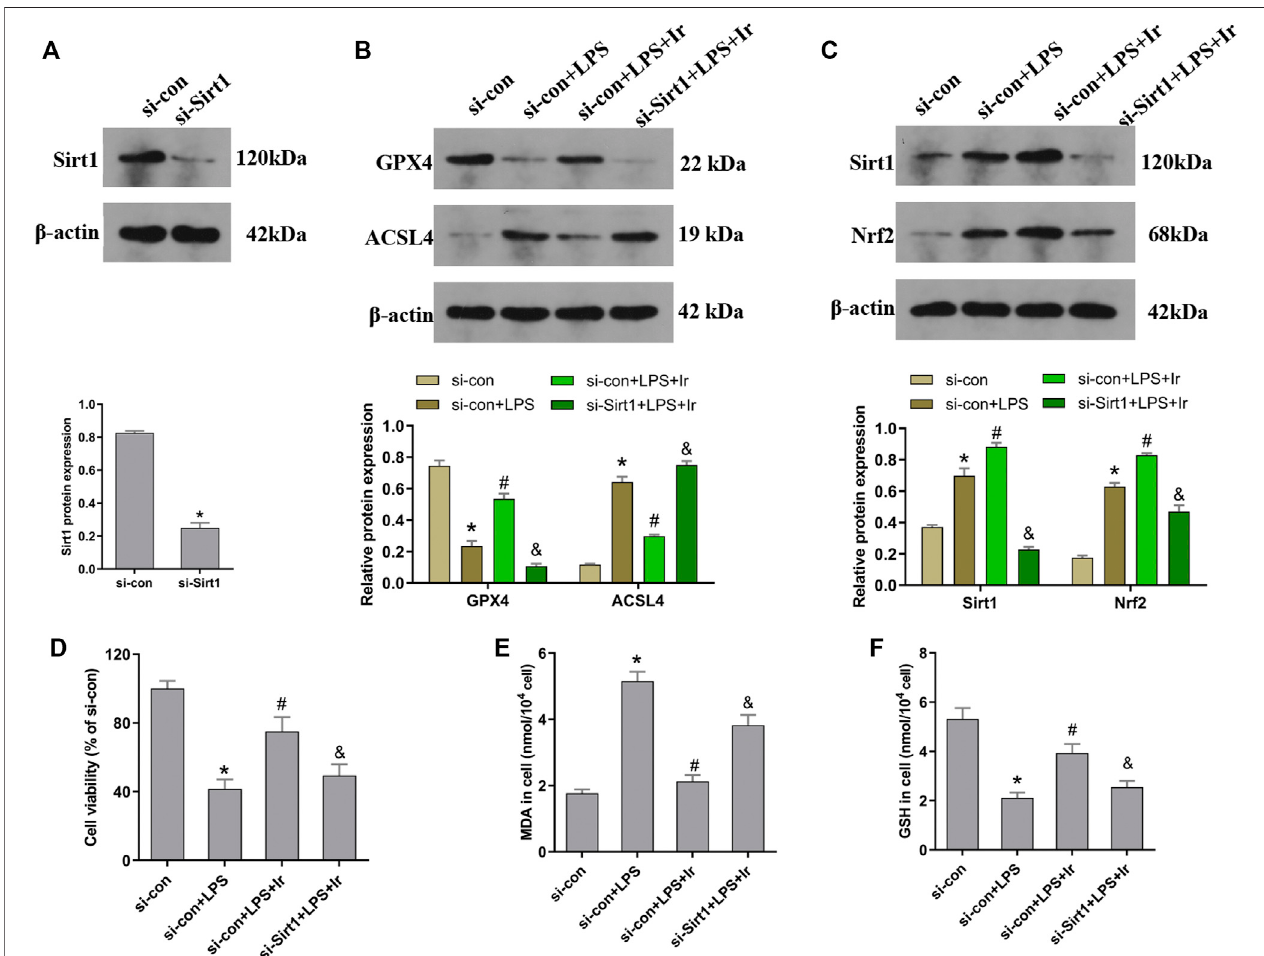
FIGURE 4 | Irisin upregulates the SIRT1/Nrf-2 pathway to inhibit LPS-induced ferroptosis. HK-2 cells were transfected with SIRT1 siRNA (si-Sirt1) or negative control(si-con)followedbyexposuretoLPSandirisin. (A) TheexpressionofSIRT1proteinincellstransfectedwithSIRT1siRNA(si-Sirt1)ornegativecontrol(si-con)was detected using Western blot to validate the knockdown of SIRT1. (B) Western blots and quantitative analyses of GPX4 and ACSL4 proteins in cells. (C) Western blots and quantitative analysesofSIRT1 and Nrf2 proteins in cells. (D) Cell viabilityusing the CCK-8 kit. The levels ofMDA (E) and GSH (F) in cellswereanalyzed using a corresponding kit. * p < 0.05 vs. si-con group, # p < 0.05 vs. si-con + LPS group, & p < 0.05 vs. si-con + LPS + Ir group. Data are presented as mean ± SD ( n = 3).